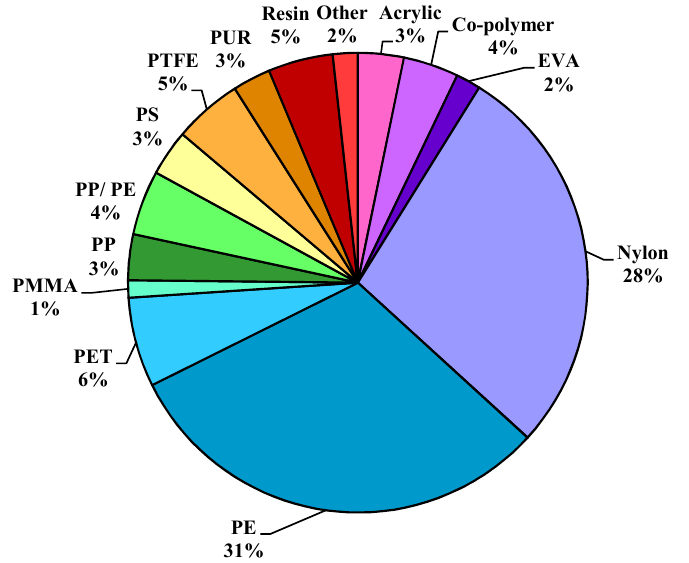
Figure 4. MP polymer types detected at sampling Site 1 (A63) throughout the 13-month sampling period. Abbreviations: EVA, ethylene vinyl acetate; PE, polyethylene; PET, polyethylene tereph- thalate; PMMA, polymethylmethacrylate; PP, polypropylene; PP/PE, polypropylene-polyethylene co-polymer; PS, polystyrene; PTFE, polytetrafluoroethylene; PUR, polyurethane; resin, including alkyd, hydrocarbon, and phenoxy